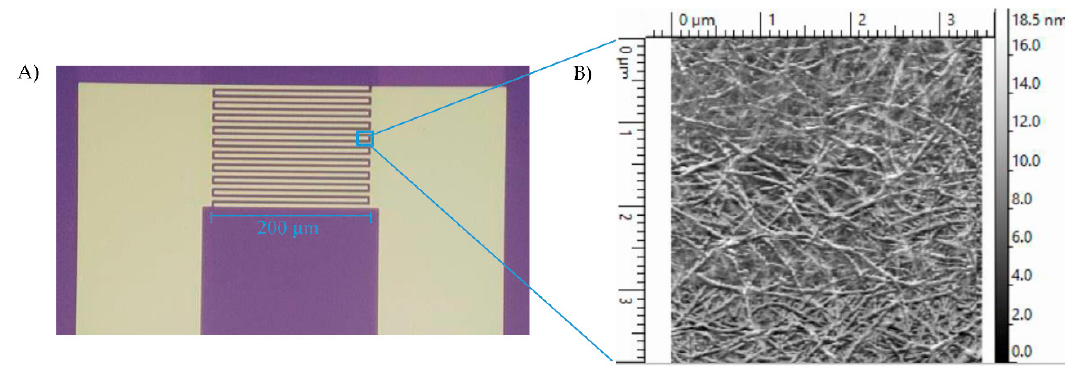
Figure 2. ( A ) Interdigitated gold electrodes on Si/SiO 2 with twenty 200 µm long and 5 µm wide digits, separated by 3 µm gaps. ( B ) AFM image of CNT-functionalized gap of interdigitated electrodes. Method results in reproducible, dense and uniform surface coverage.